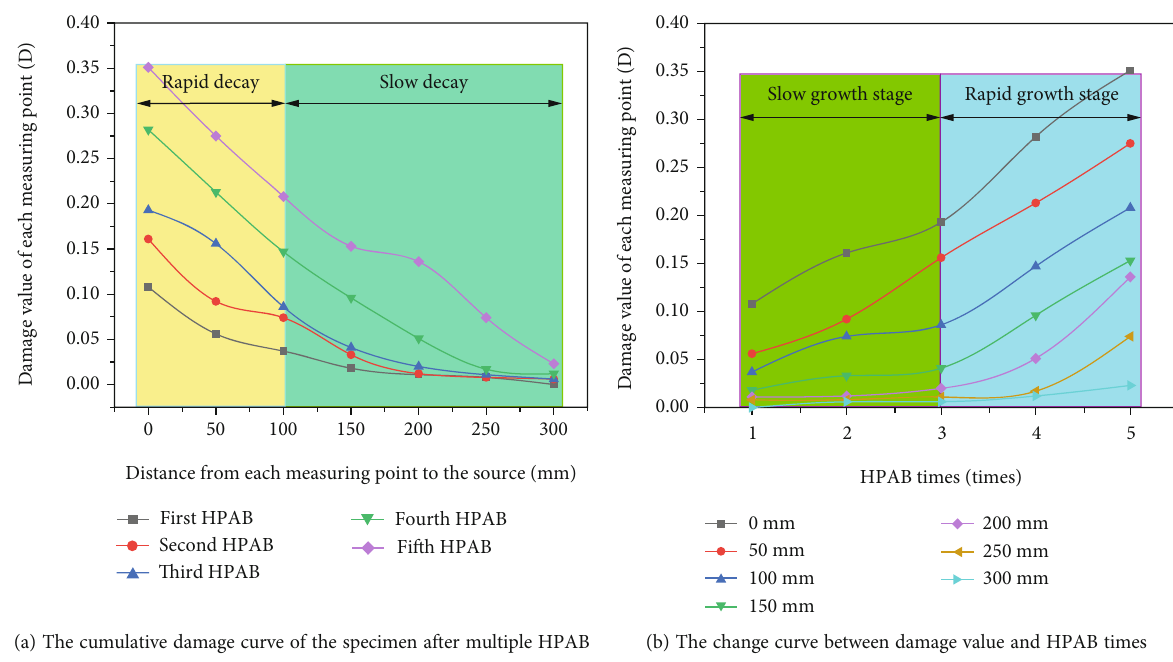
Figure 6: Cumulative damage curve of the specimen under multiple HPAB tests. Table 5: Vibration velocity results of each measuring point under multiple HPAB